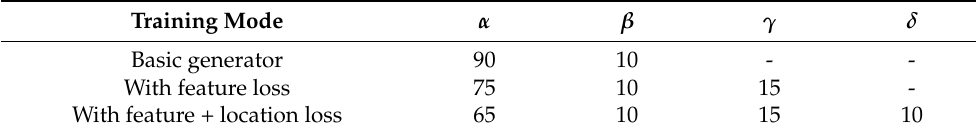
Table 1. The weight percentages for the generator loss components. Training Mode α β γ δ Basic generator 90 With feature loss 75 With feature + location loss